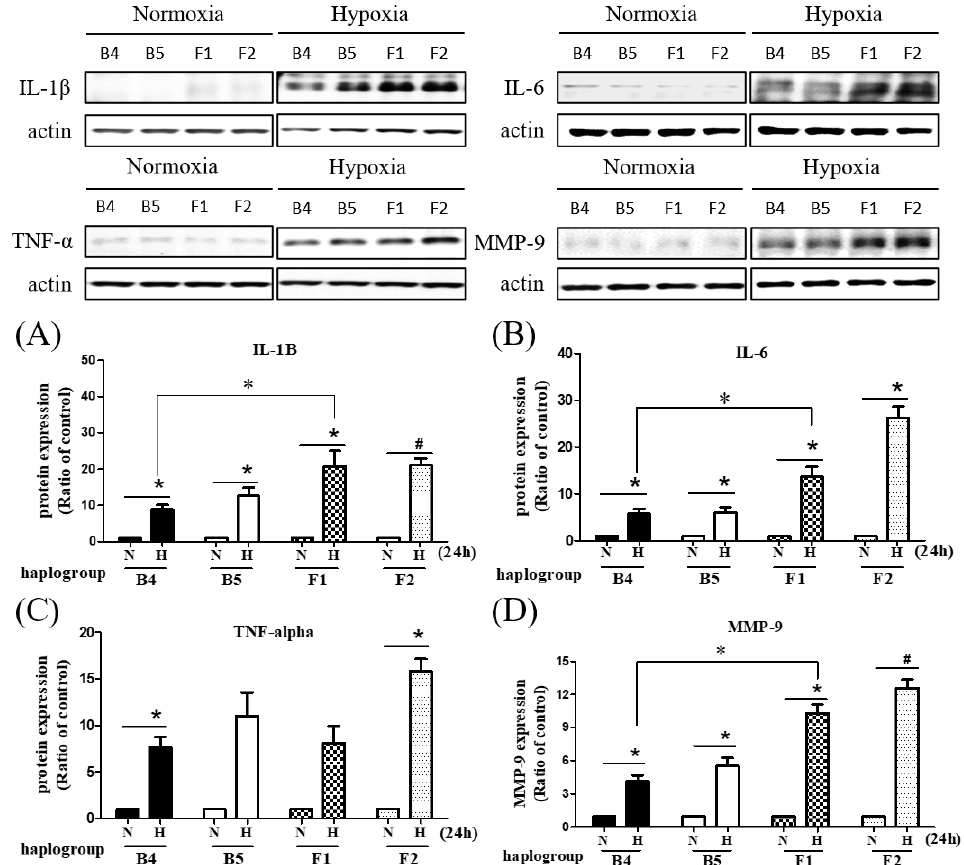
Figure 4. The expression of inflammatory markers and extracellular matrix in di ff erent cybrids after hypoxia-ischemia. Comparisons of inflammatory cytokines in cybrid cells harboring stroke-susceptible haplogroup F and resistant haplogroup B. Western blot analysis shows hypoxia induced protein expression of IL-1 β ( A ), IL-6 ( B ), TNF- α ( C ), and MMP-9 ( D ). Actin was used as loading controls. Data represent the mean ± SD of at least three independent experiments ( * p < 0.05; # p < 0.005). N was used to represent normoxic and H to represent the hypoxic